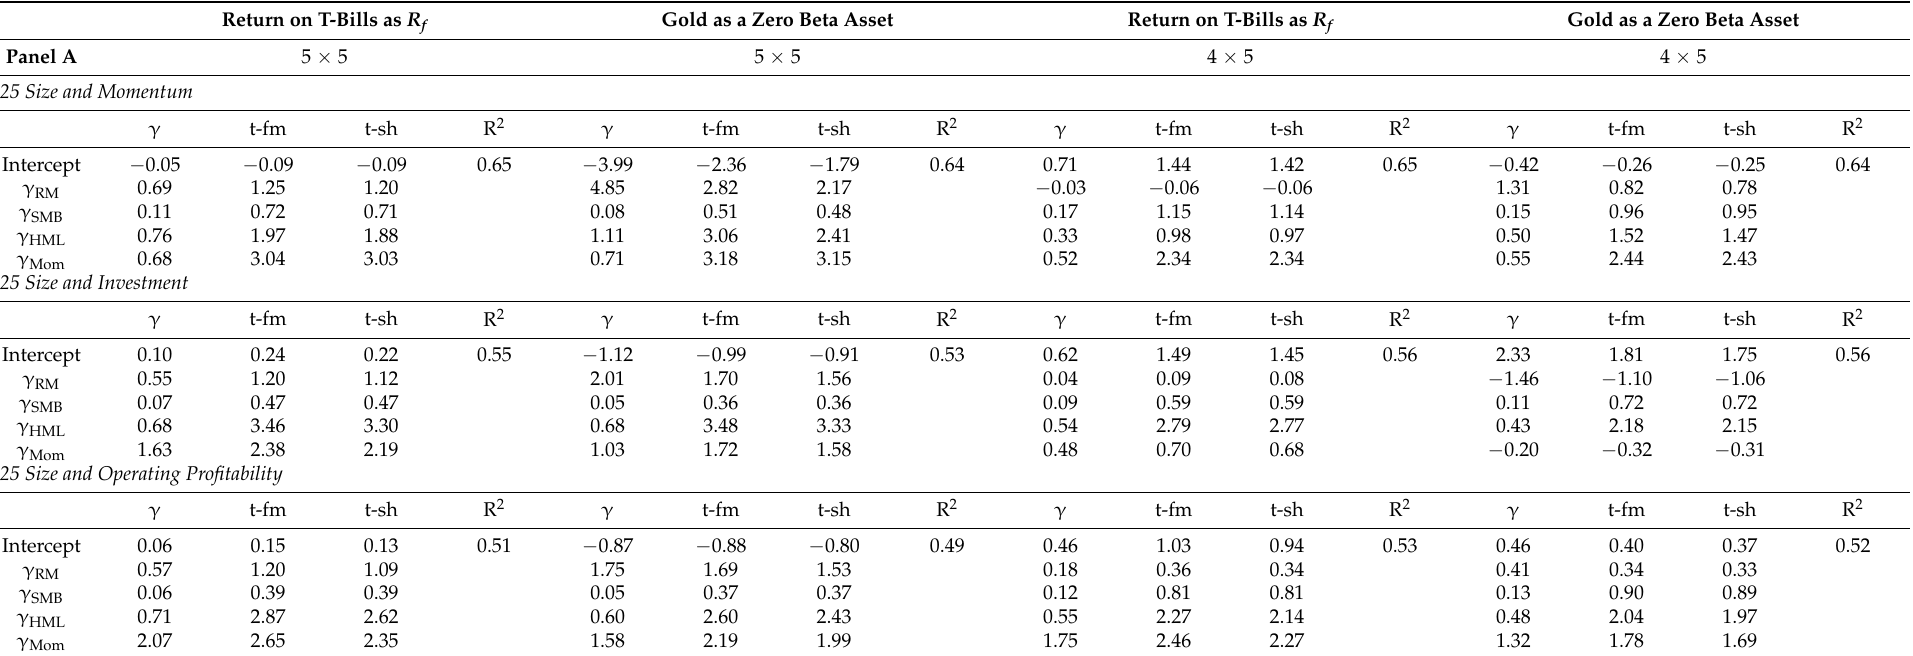
Table 12. Fama–MacBeth tests for four-factor and G-four-factor from January 1981 to December 2015. Results represent monthly percent returns. Panel A shows results on 25 size and momentum, 25 size and investment, and 25 size and operating profitability portfolios. Panel B shows results on 25 size and variance, 25 size and residual variance, and 25 size and market beta portfolios. Panel C shows results on 32 size, book-to-market, and operating profitability; 32 size, book-to-market, and investment; and 32 size, operating profitability, and investment portfolios. Panel D shows results on 35 size and net share issues portfolios. Results for all test portfolios are shown with (5 × 5) and without microcaps (4 × 5); γ is the average coefficient, t-fm is the t-statistics from Fama–MacBeth procedure, t-sh is the Shanken (1992) errors-in-variables corrected t-statistic, and R 2 is the average cross-sectional R-Squared of the tested